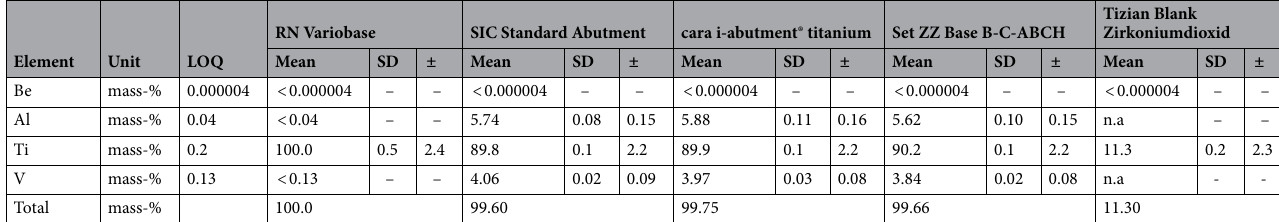
Table 8. ICP-OES results of metallic and non-metallic implant abutment materials. LOQ limit of quantitation, SD standard deviation, ± : measurement uncertainty, n.a. not available.